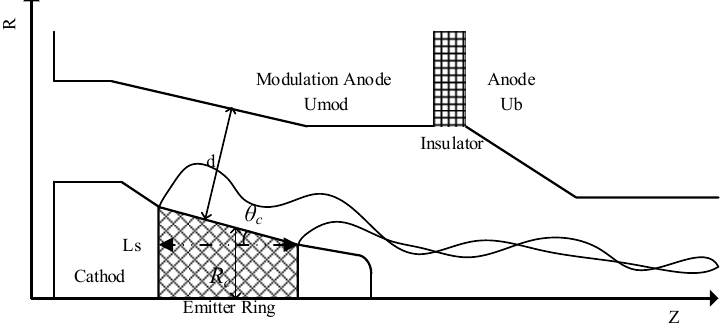
Figure 2. Schematic outline of the MIG.